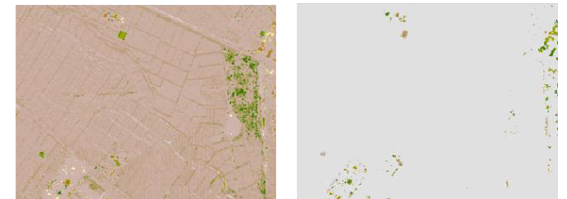
Figure 5b. Height threshold eliminated ground features.